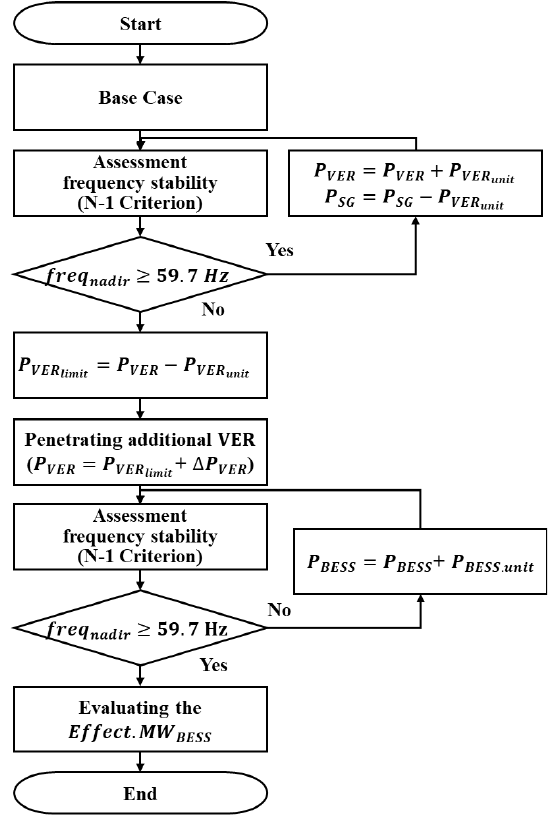
Figure 3. Flowchart of the evaluation procedure for analyzing the frequency response contribution effect of BESS.